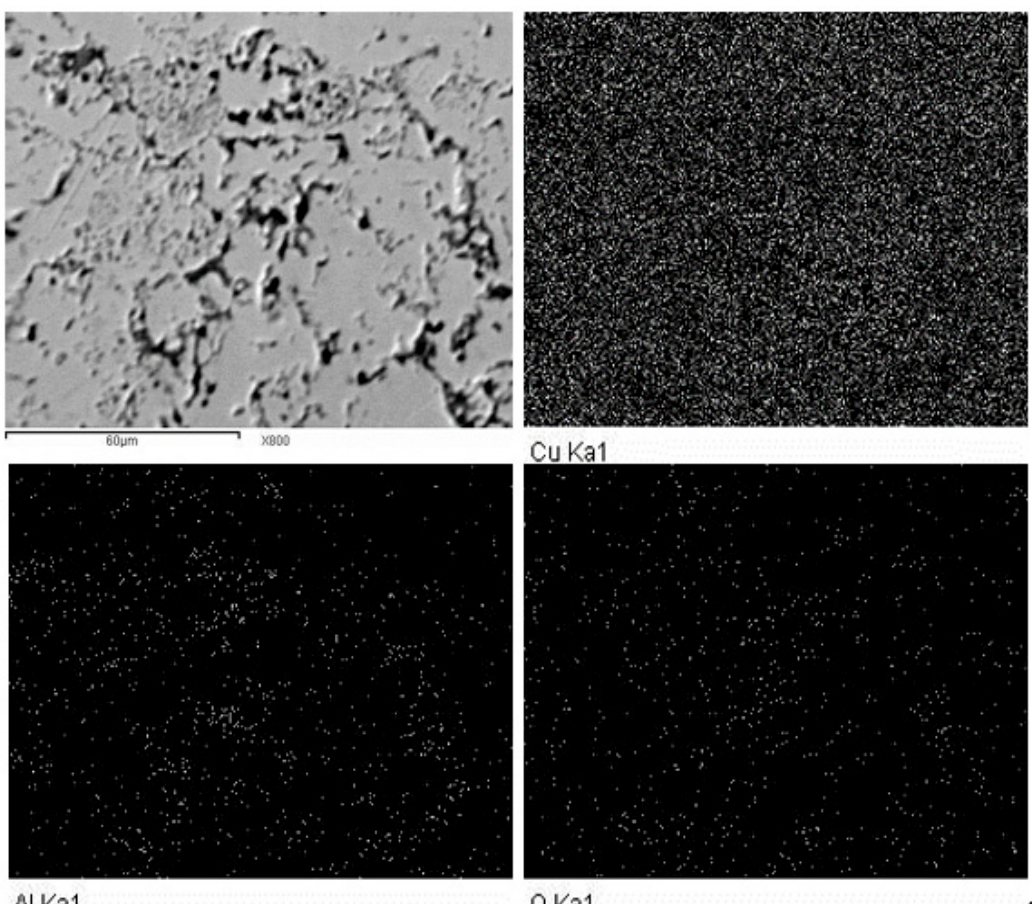
Figure 5. Mapping and EDS analysis of Cu-12.5%Al 2 O 3 nanocomposite.